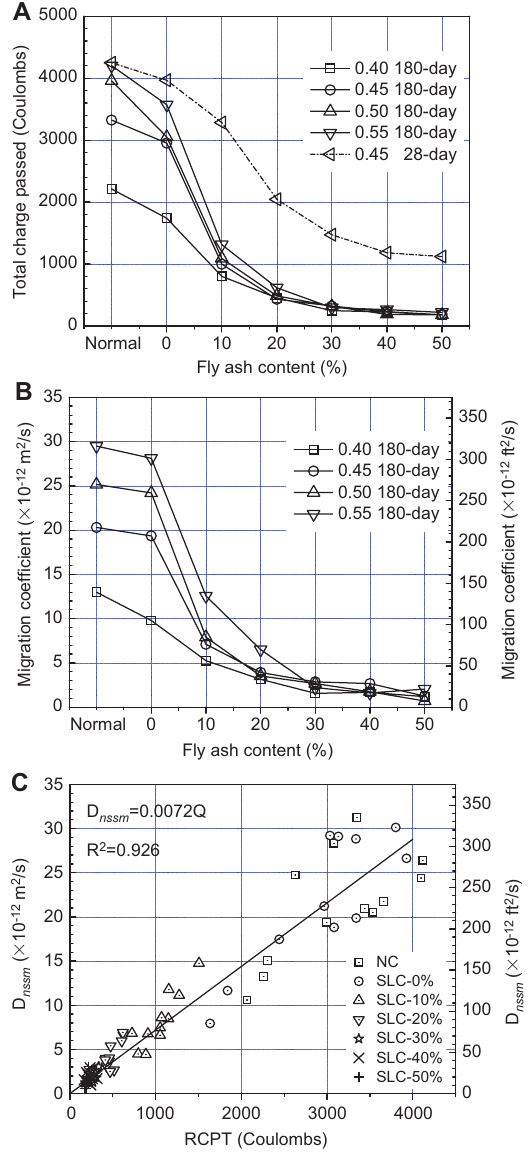
Figure 8 (A) RCPT, (B) D crete of different w/c